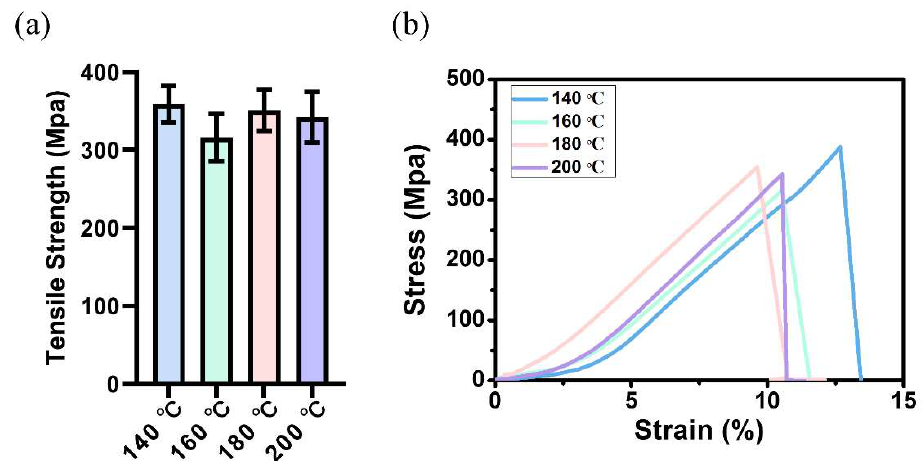
Figure 7. ( a ) Tensile strength; ( b ) stress-stain curves of CFRPs molded at different temperatures. To determine the bending strength and bending modulus, each specimen was cut to dimensions of 100 × 13 × 3.75 mm 3 according to ASTM D790-10. Figure 8a,b show the bending strength and bending modulus, respectively. The bending strength and bending modulus of the CFRPs molded at 140 °C were higher than those of the samples molded at other temperatures.